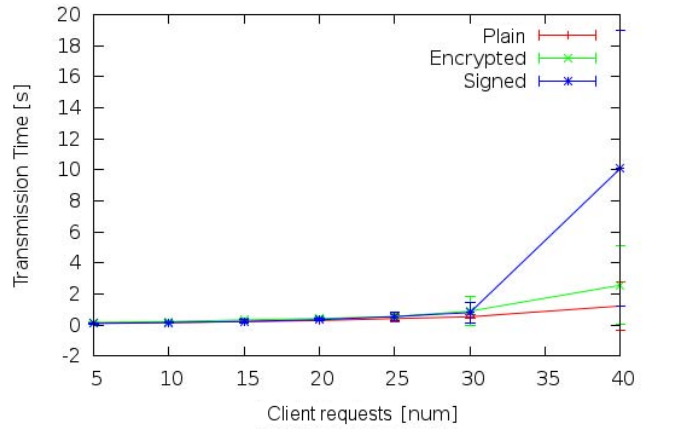
Figure 9. Transmission time between client and CM devices on domain